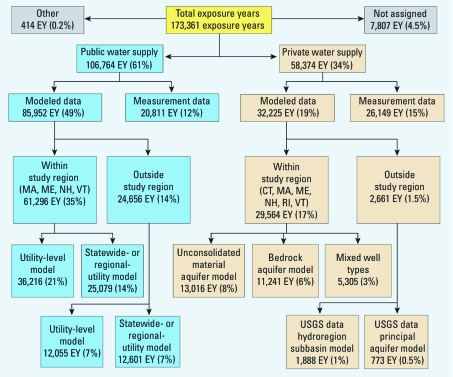
Number and percentage of EYs by each method for assigning residential water supply. “Not assigned” refers to locations outside the United States; “other” refers to EYs for which there was insufficient information to assign.